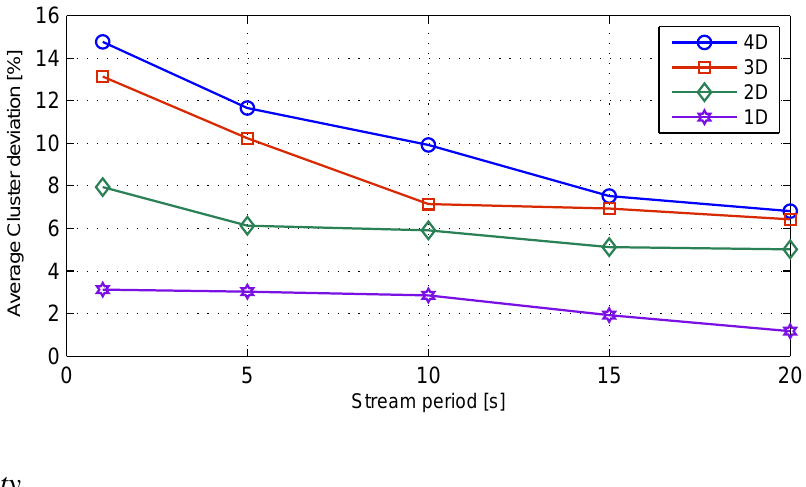
Figure 9. Average cluster deviation variation with stream